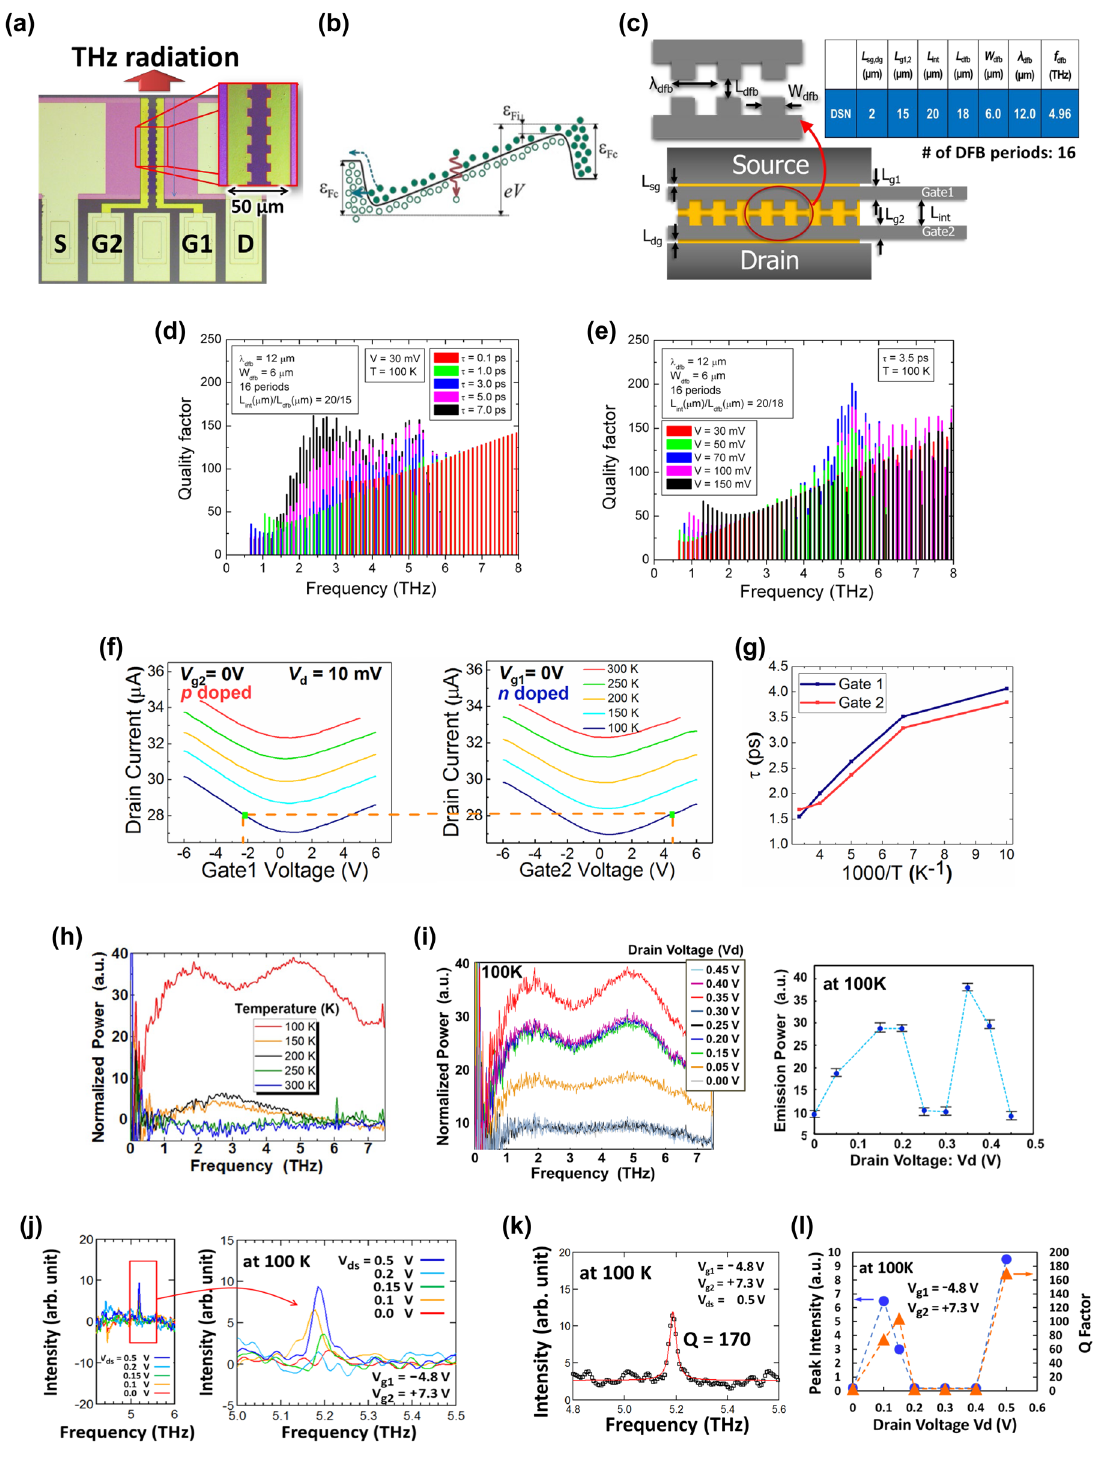
Figure 1: First experimental demonstration for THz single-mode emission and THz amplified broadband spontaneous emission (ASE) in